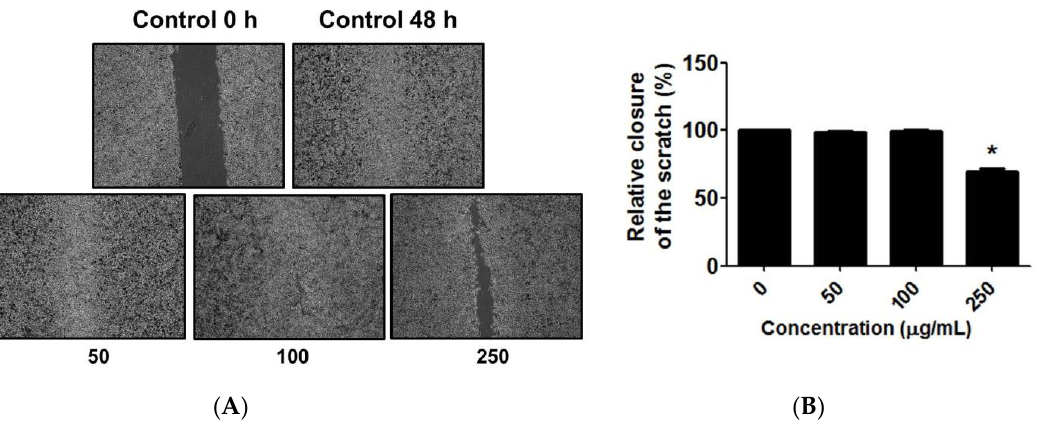
Figure 8. ( A ) Migration of untreated A549 cells and A549 cells treated with 50, 100, and 250 µ g/mL C. chinense leaf extract, and ( B ) percentage of relative closure of the scratch of untreated A549 cells and A549 cells treated with 50, 100, and 250 µ g/mL of C. chinense leaf extract. The data represent the mean ± SD of the three independent experiments with * p <